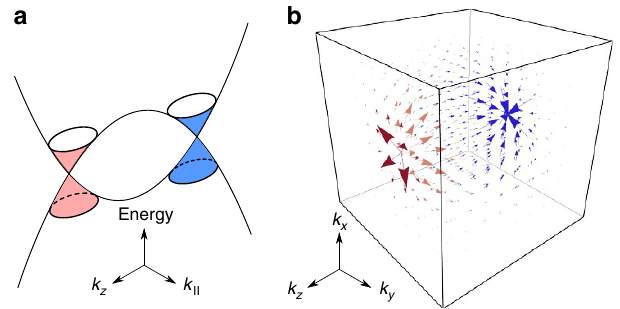
Figure 1 | Nontrivial band structure and Berry curvature of a topological semimetal. ( a ) A schematic of the energy spectrum of a topological semimetal. ( k x , k y , k z ) is the wave vector. k 2 ¼ k 2 x þ k 2 y . ( b ) The vector plot j j of the Berry curvature in momentum space. The conduction and valence bands of a topological semimetal touch at the Weyl nodes, at which a pair of monopoles is hosted. The arrows show that the flux of the Berry curvature flows from one monopole (red) to the other (blue), defining the nontrivial topological properties of a topological